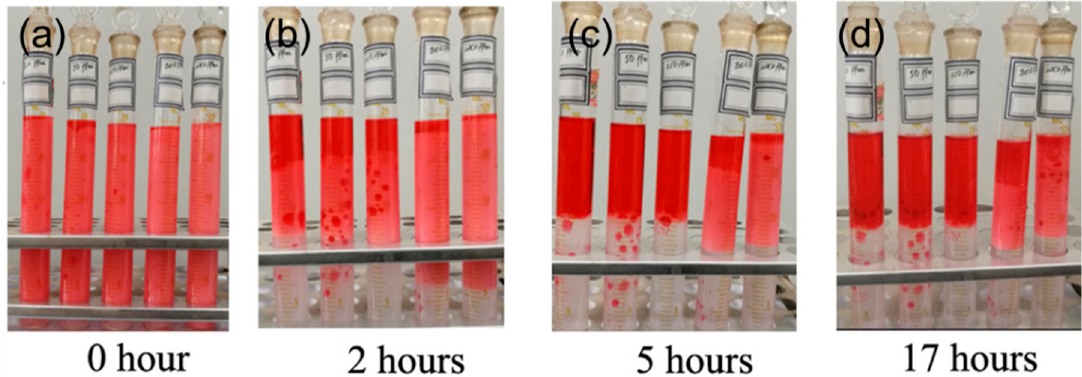
Figure 11. Gravity separation process ( a ) 0 h, ( b ) 2 h, ( c ) 5 h, ( d ) 17 h. Operating condition O/W = 20/80, HPAM = 50 ppm, shear rate = rpm.